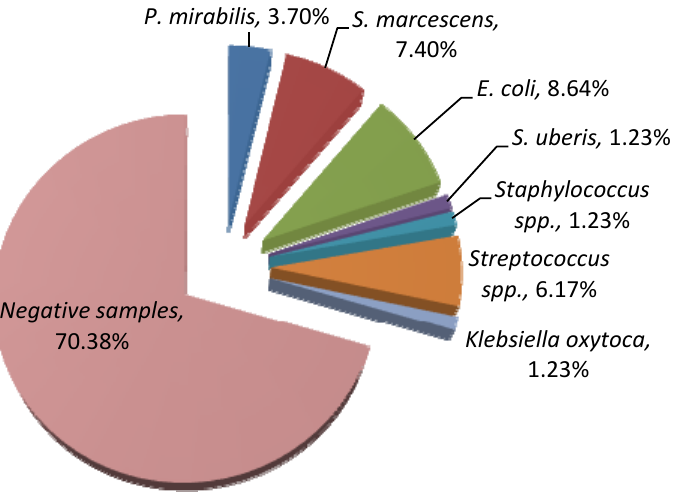
Figure 1. Prevalence of mastitis-causing pathogens in the collected milk